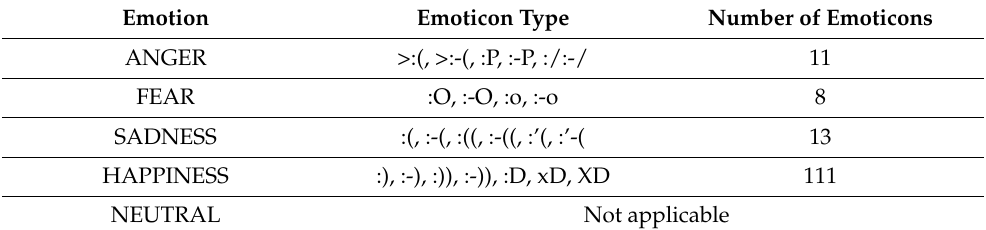
Table 6. Emotions in the CC text